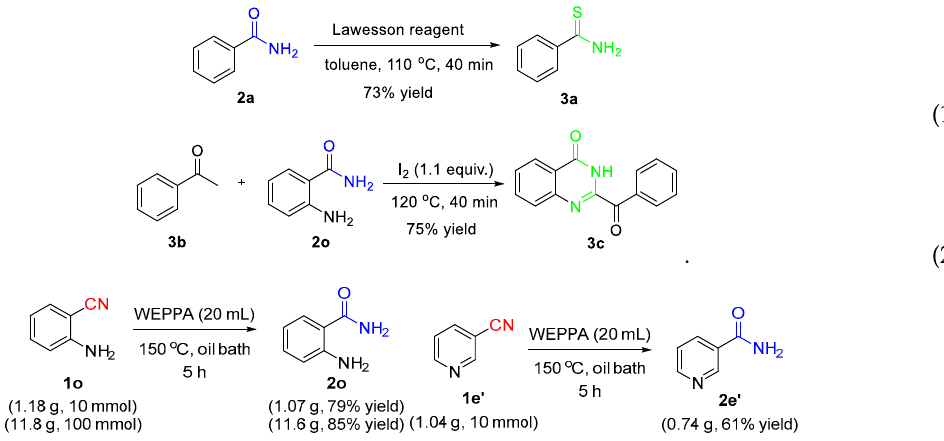
Molecules 2019 , 24 , x FOR PEER